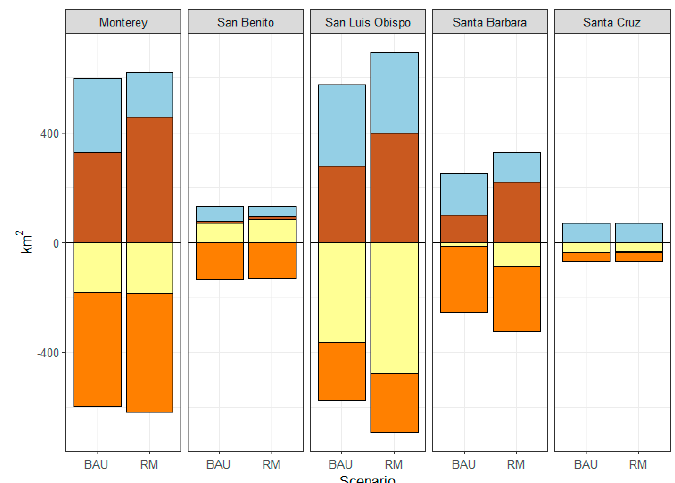
Figure 3. Projected change in land use and land cover from 2001–2100 under a business-as-usual (BAU) and recent modern (RM) scenario for each county in the California’s Central Coast region, expressed as average net change in annual cropland (orange), perennial cropland (brown), development (blue), and rangeland (yellow) across the modeled period and 10 Monte Carlo simulations.